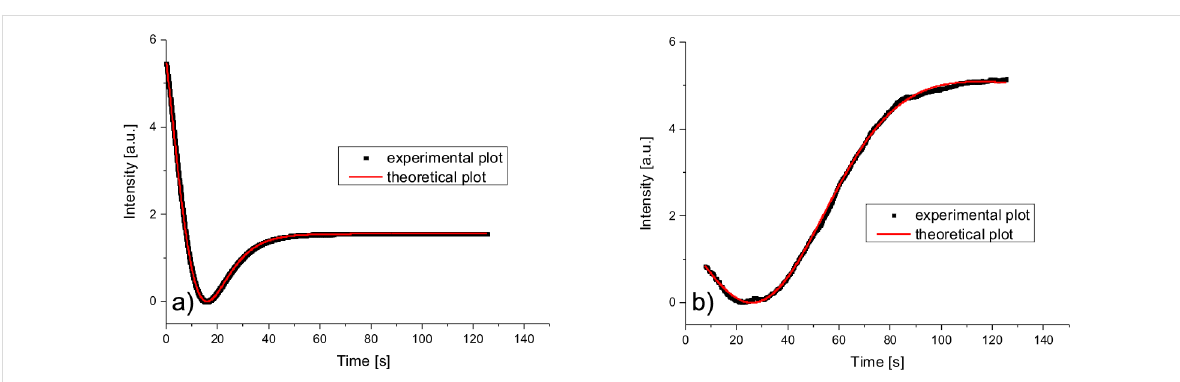
experimental plot has just one minimum. Thus, no deviation angles larger than 0.1 rad can be obtained.